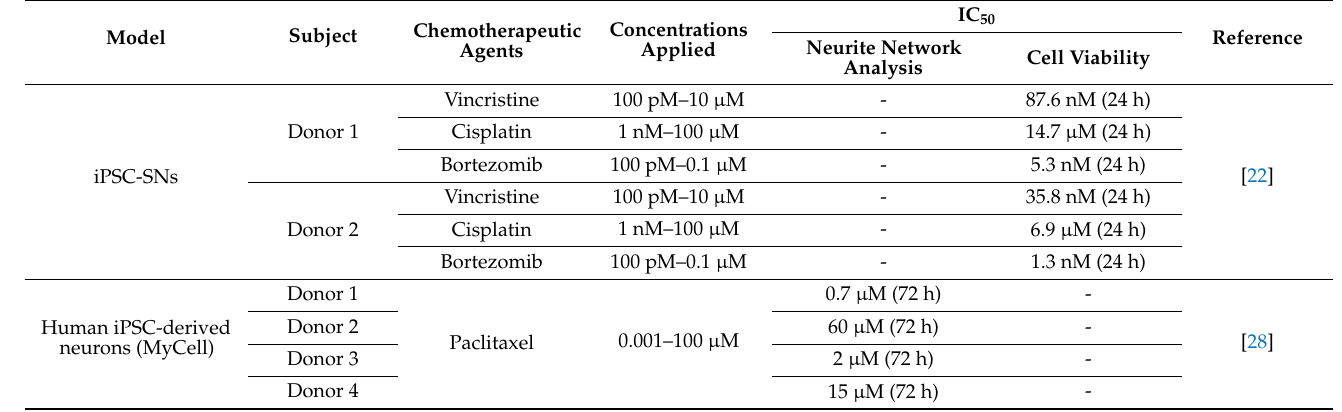
Table 3. Donor backgrounds affect the half-maximal inhibitory concentration (IC 50 ) of various chemotherapeutic agents in human induced pluripotent stem cell-derived